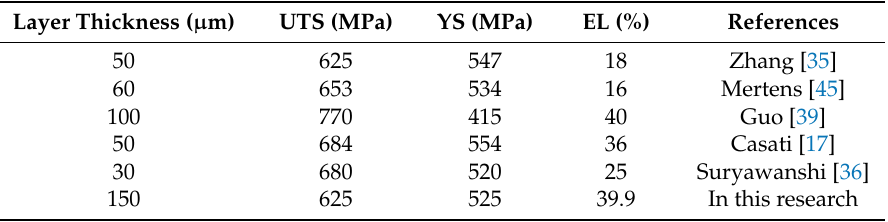
Table 6. Summary of Tensile properties with different layer